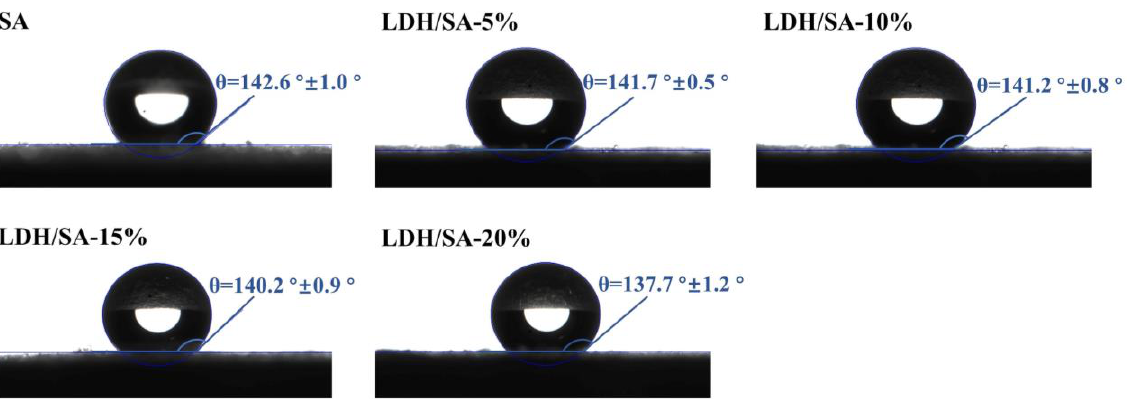
Figure 8. Contact angles of the pure SA and LDH/SA composites.